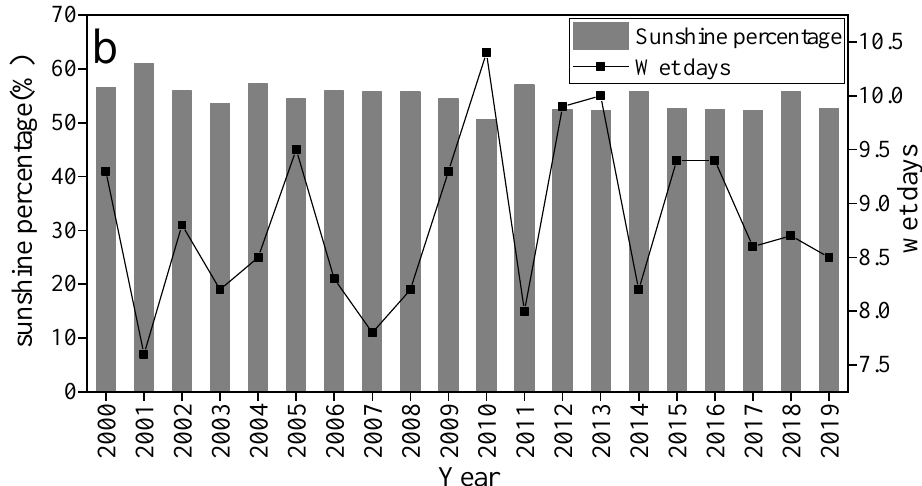
Figure 2. Trends in the annual mean value of temperature and precipitation ( a ) and sunshine percentage and wet days ( b ) during 2000–2019 in the study area.